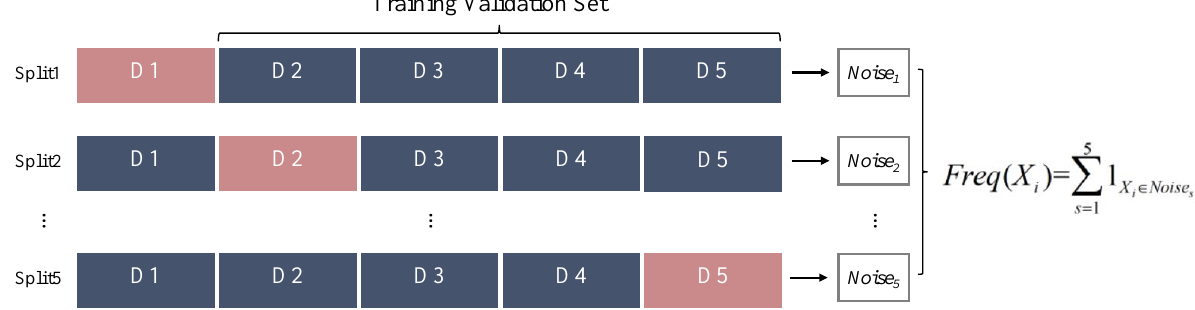
Figure 3. The outer loop of EIRS- k GNN to detect label